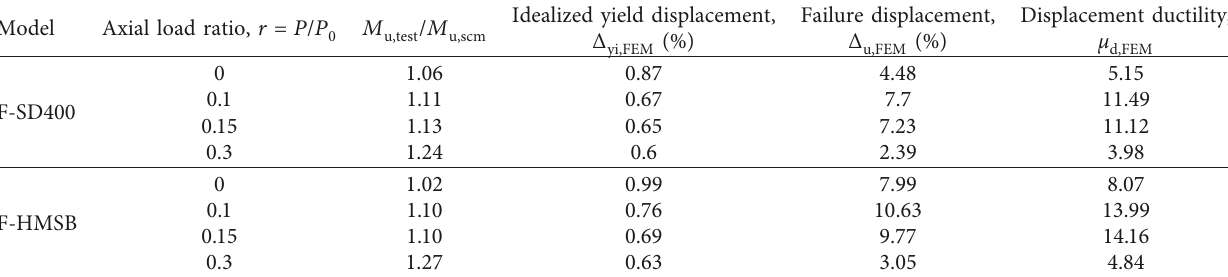
Table 6: Summary of the parameter analysis